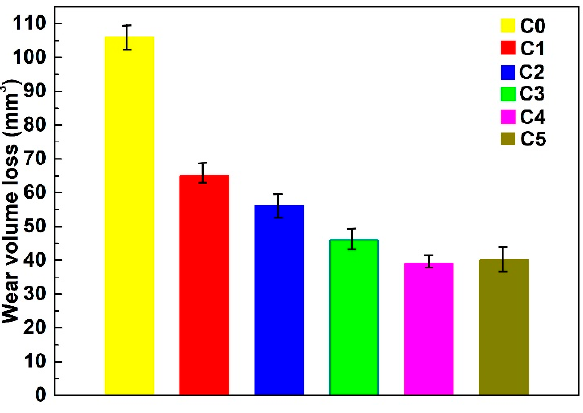
Figure 8. Wear volume loss of the composite coatings.